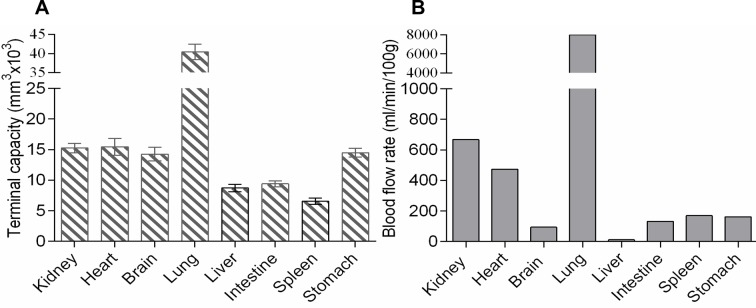
Correspondence between morphometric and hemodynamic parameters.(A) TC values were in good agreement with organ blood flow rates, estimated by a physiological method[40] (B). Data on (A) are mean ±SEM, on (B)–mean values.